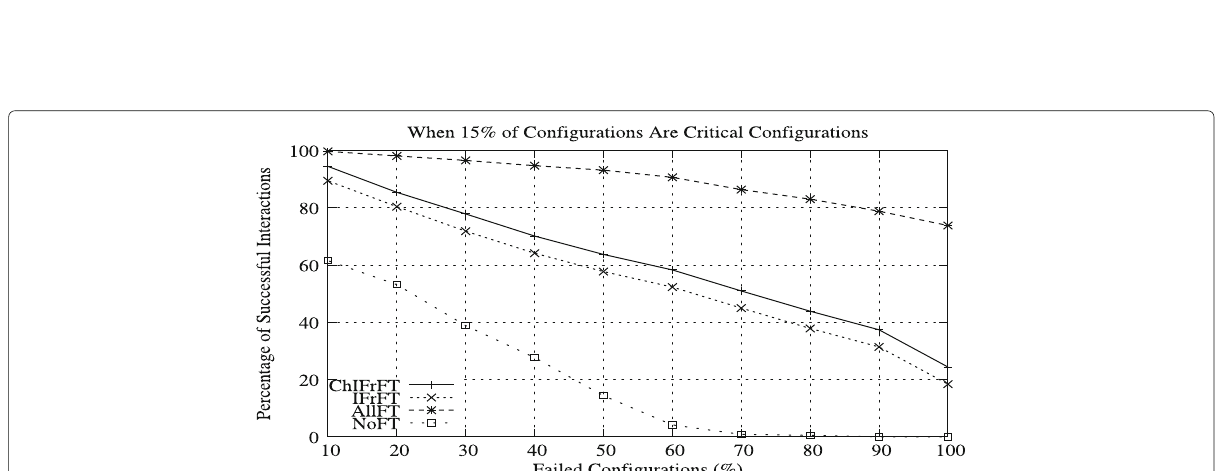
Fig. 11 Critical configurations are 15% of all